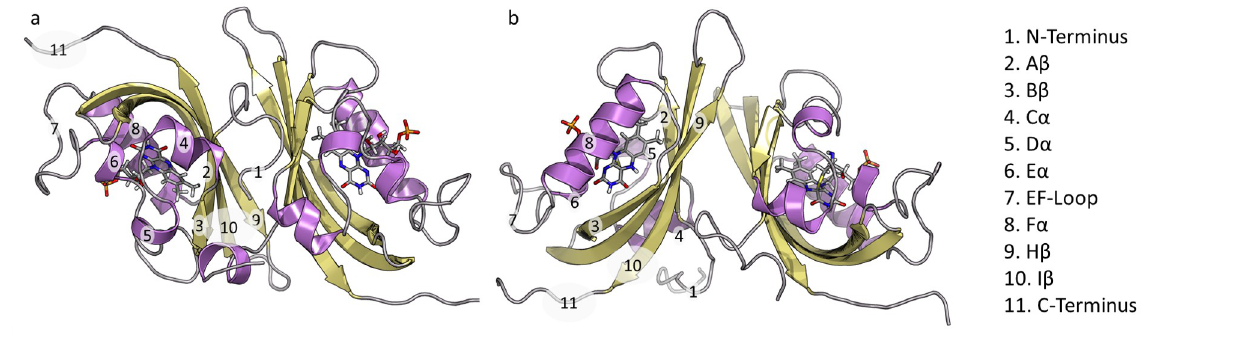
Fig 1. Crystal structures of ZTL dimers: a) Anti-parallel dark state; b) Parallel light state.